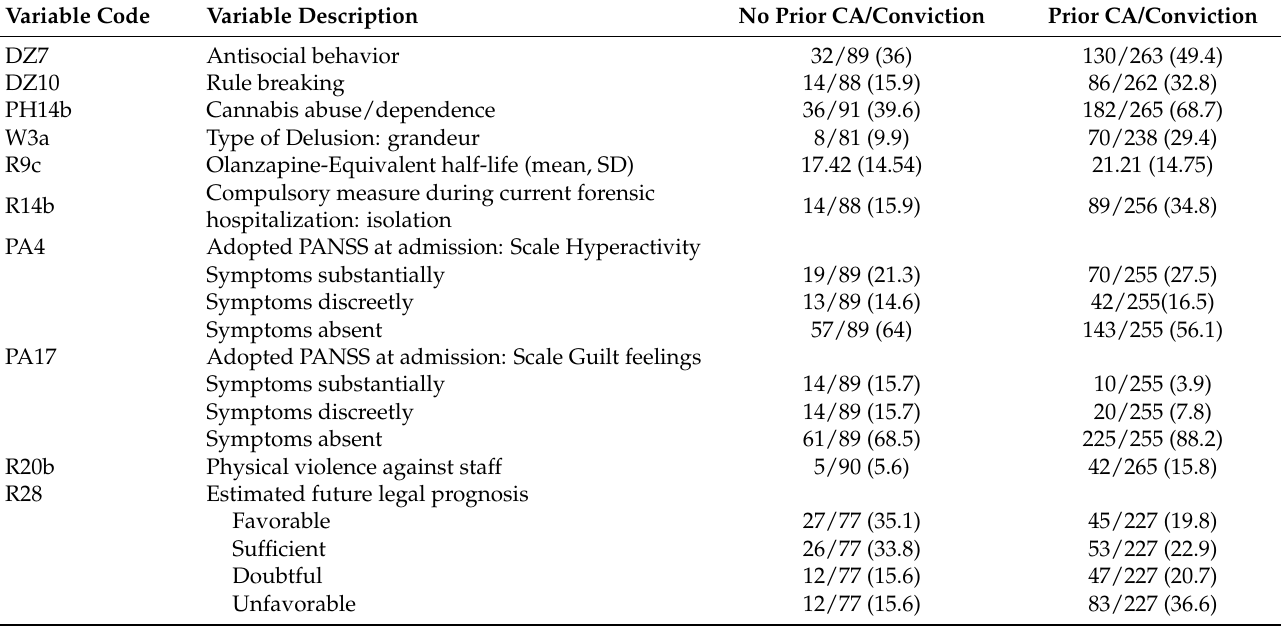
Table 3. Absolut and relative distribution of predictor variables most